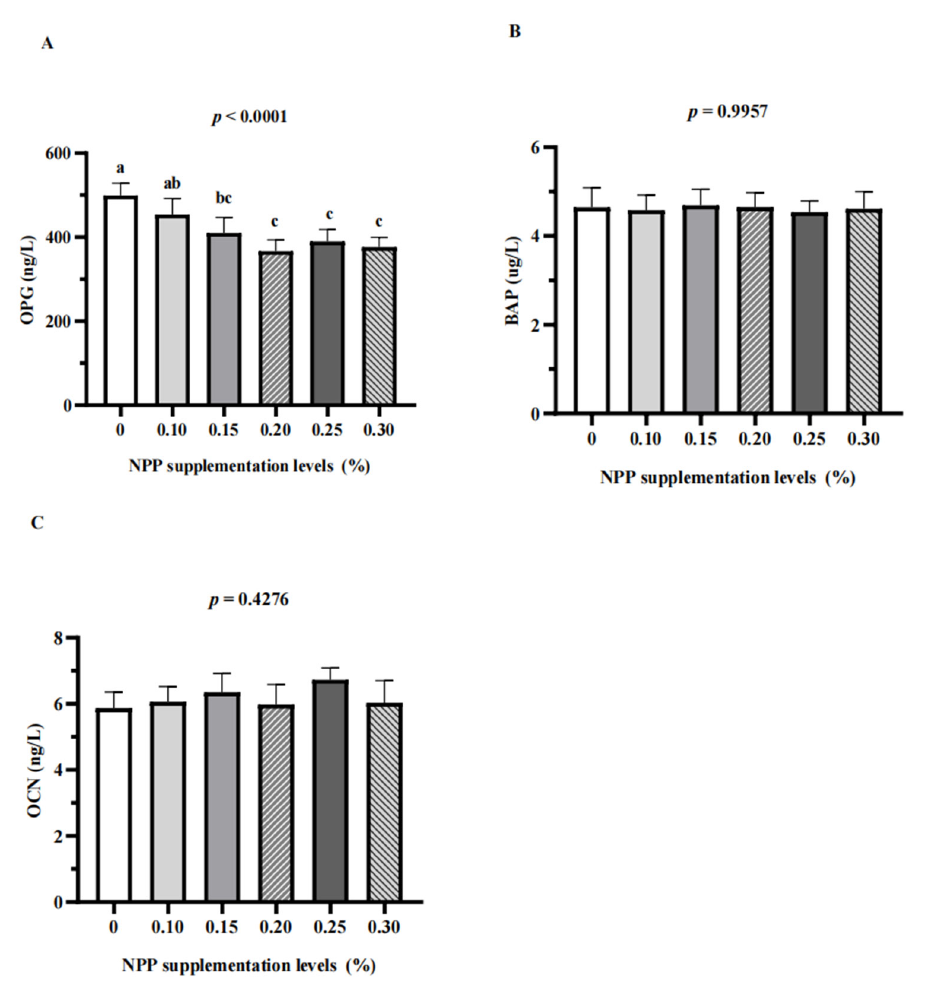
Figure 4. E ff ect of the level of dietary NPP supplementation on the serum bone resorption markers of Hy-Line Brown laying hens (69–78 weeks of age) fed a phytase-containing diet. OPN = osteopon- tin ( A ); TRACP-5b = tartrate-resistant acid phosphatase 5b ( B ); CTX-I = C-telopeptide of type-I col-